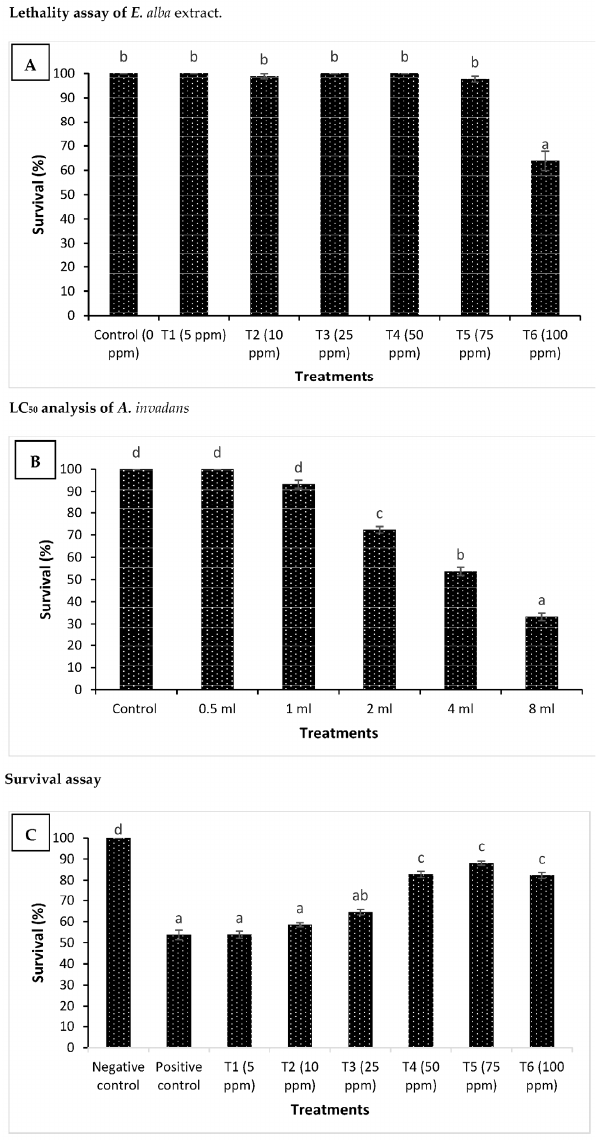
Figure 5. Eclipta alba (Bhringaraj) methanolic leaf extract treatment protects Heteropneustes fossilis fingerlings against Aphanomyces invadans challenge. ( A ) Toxicity of methanolic leaf extract to H. fossilis fingerlings. The fingerlings were treated with extract at the indicated doses for 168 h. The non-treated fingerlings served as control. Survival was recorded 168 h post-treatment. Error bars represent the standard error of five replicates; different letters indicate significant differences ( p < 0.05). ( B ) The proportion of survived H. fossilis fingerlings after 168 h post-challenge with A. invadans . Five infectious doses (0.5, 1, 2, 4, and 8 mL suspension of 100+ motile zoospores/litre of water) were tested in the H. fossilis fingerlings. The A. invadans dose provoking significant mortality near to 60% at 168 h in H. fossilis fingerlings was considered an optimum dose and was selected for the experimental challenge. The unchallenged served as control. Values are presented as mean ± SE ( n = 3). ( C ) Survival (%) of H. fossilis fingerlings treated with methanolic leaf extract after 168 h of challenge with A. invadans . The fingerlings were treated with leaf extract at the indicated doses and subsequently challenged with A. invadans at 4 mL suspension of 100+ motile zoospores/liters of water. Non-pretreated larvae that were either challenged with A. invadans (positive control) or unchallenged (negative control) served as controls. Error bars represent the standard error of five replicates; different letters indicate significant differences ( p <